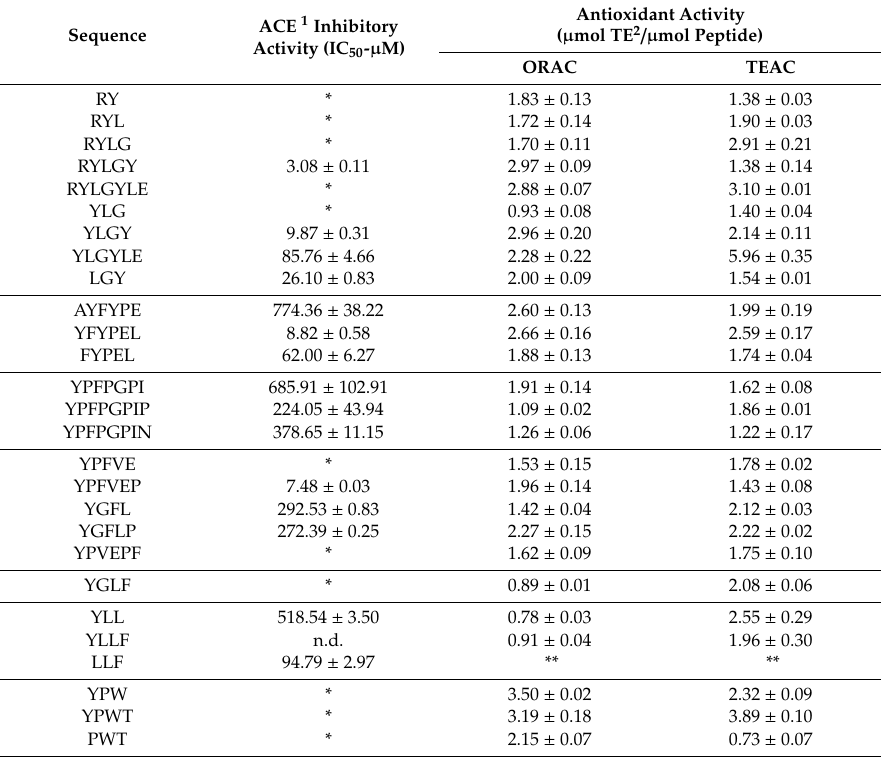
Table 4. ACE-inhibitory activity (expressed as µ M) and antioxidant activity (expressed as µ mol Trolox equivalents (TE) / µ mol peptide of synthetic animal-protein derived peptides.